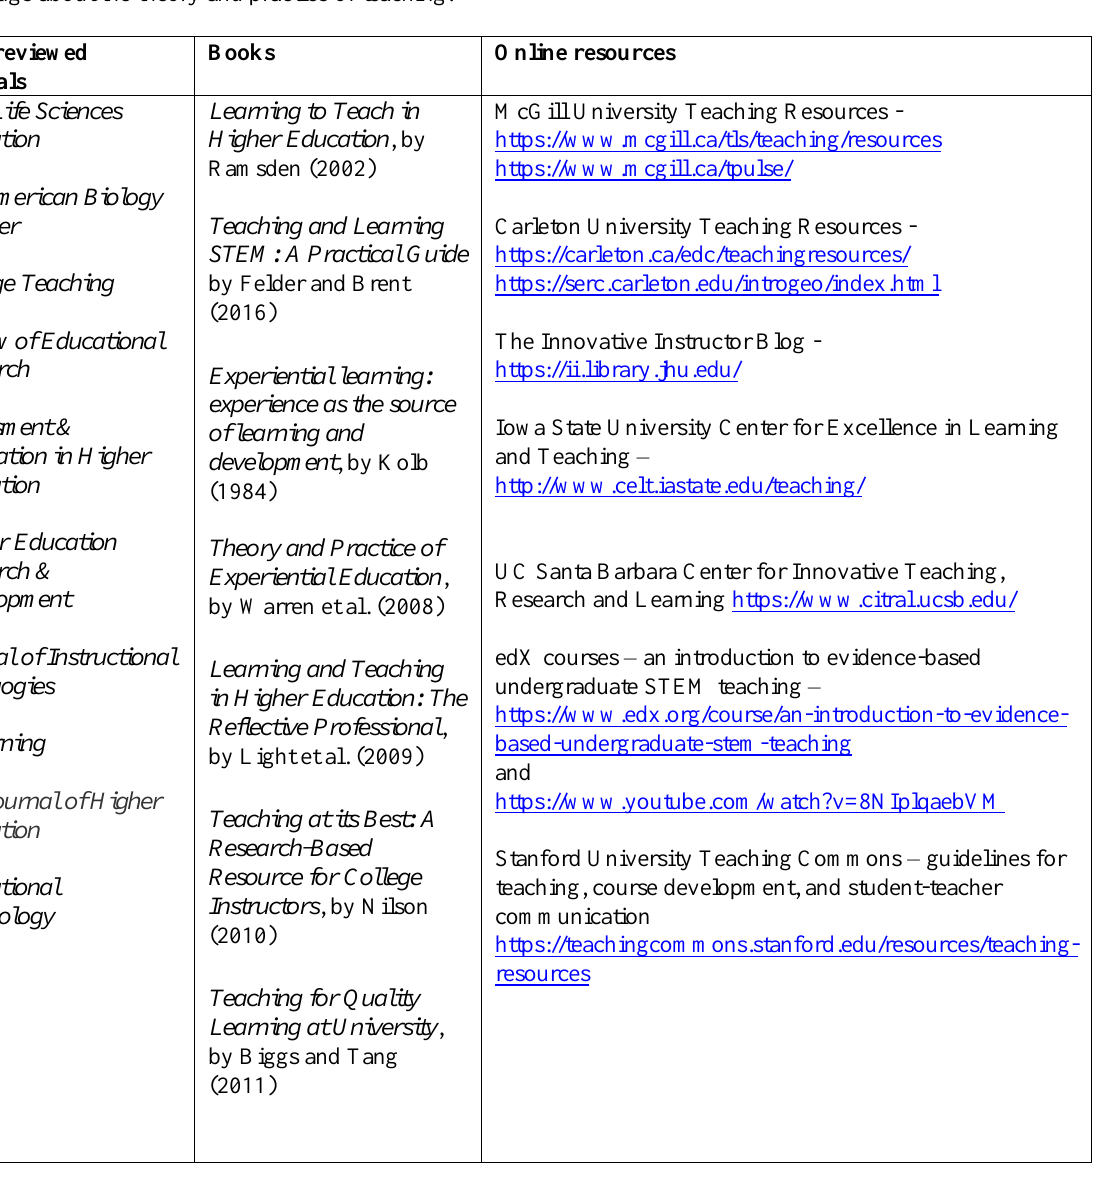
Table A1 . Some examples of resources available for instructors to develop their teaching techniques or their knowledge about the theory and practice of